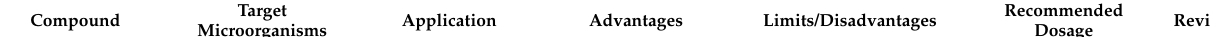
Table 2. Main chemical compounds with antimicrobial activity used to replace/reduce SO 2 addition in